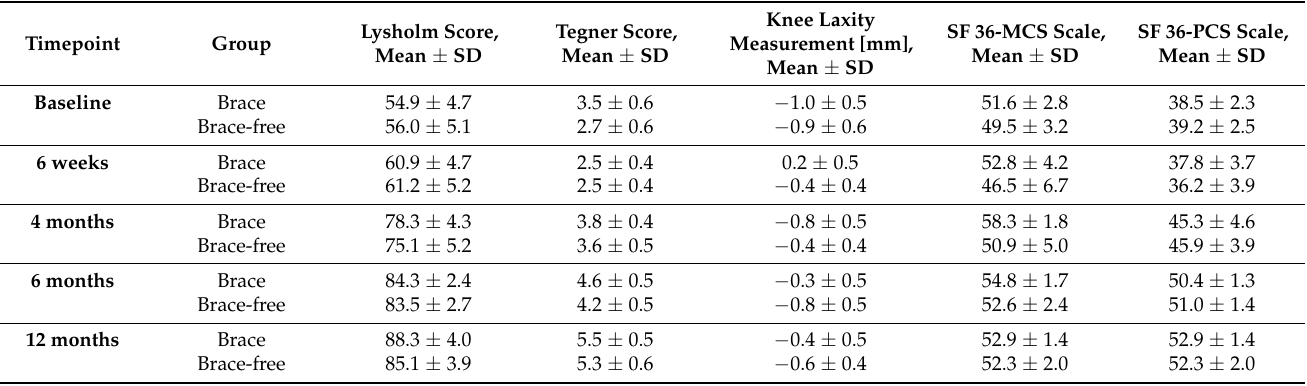
Table 5. Secondary outcome of Lysholm and Tegner Score, KLT measurements, SF36-MCS and PCS subscales.